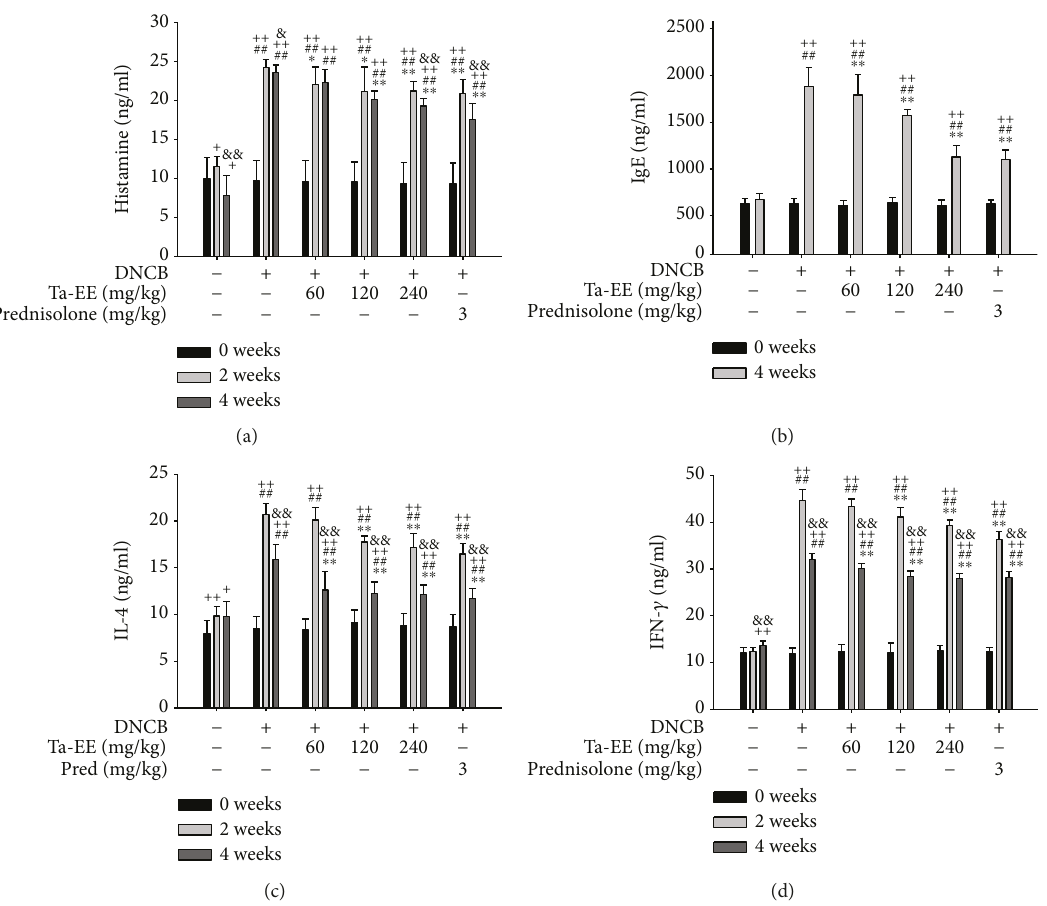
Figure 2: E ff ects of Ta-EE on the serum levels of allergic and proin fl ammatory substances and cytokines in DNCB-induced AD mice. DNCB-induced AD mice were orally administered with either Ta-EE (0, 60, 120, and 240mg/kg) or prednisolone (3 mg/kg) once a day for 4 weeks. The secreted levels of (a) histamine, (c) IL-4, and (d) IFN- γ in the sera of AD mice were measured at weeks 0, 2, and 4. The secreted level of (b) IgE in the sera of AD mice was measured at weeks 0 and 4. ∗ P < 0 05 and ∗∗ P < 0 005 versus a control group; ## P < 0 005 versus a normal group; + P < 0 05 and ++ P < 0 005 week 0 versus week 2 or 4; & P < 0 05 and && P < 0 005 week 2 versus week